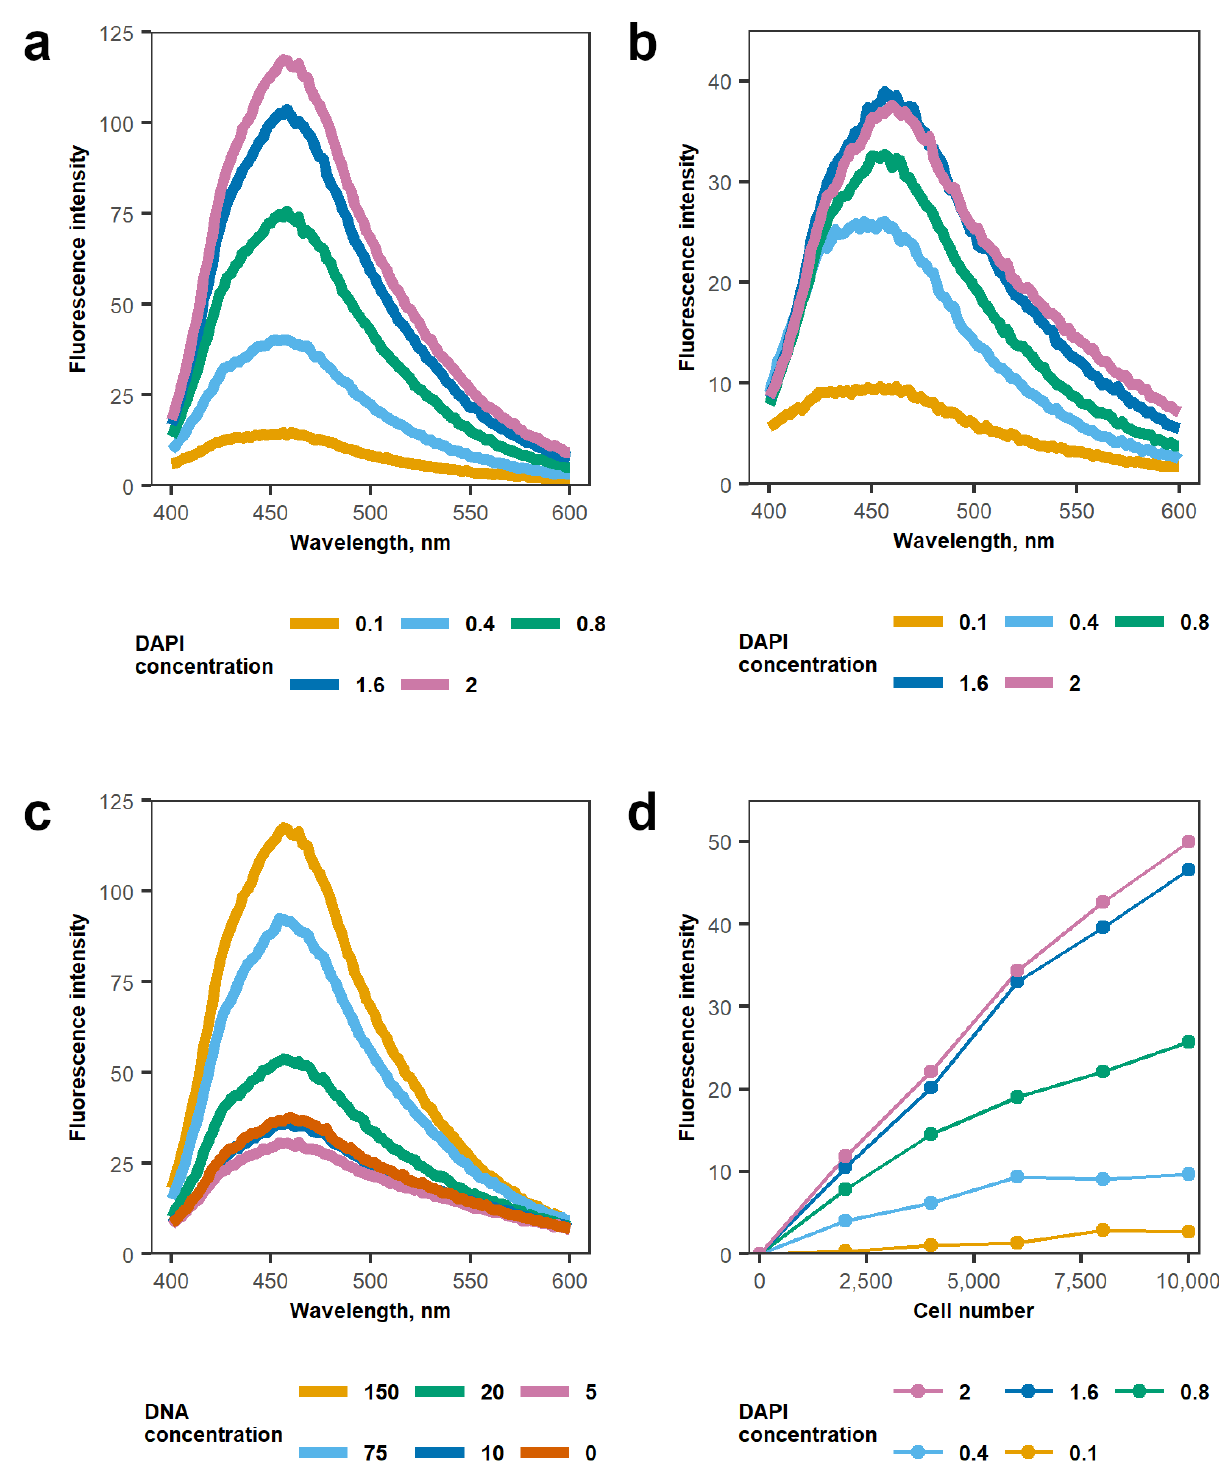
Figure 2. Evaluation of optimal working concentrations of DAPI. Fluorescence signals of: ( a ) various DAPI concentrations: 0.1, 0.4, 0.8, 1.6, and 2 µ g/mL with 150 ng/mL DNA; ( b ) the same concentrations of DAPI, but without DNA; ( c ) 2 µ g/mL DAPI with various DNA concentrations: 5, 10, 20, 75, and 150 ng/mL; ( d ) exposure of MH-22a cells to the different DAPI concentrations: 0.1, 0.4, 0.8, 1.6, and 2 µ g/mL. ( a – c ) line graphs depict fluorescence sweep data, ( d ) curves represent DNA-DAPI fluorescence intensity values. Data for a, b, c, and d were obtained from three independent